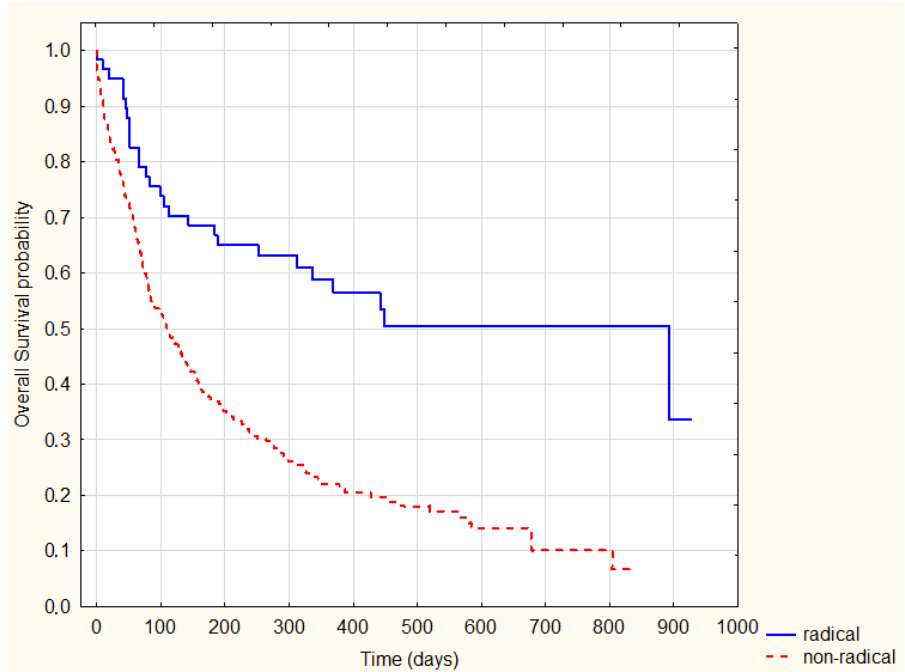
Figure 2. Kaplan–Meier Survival Analysis—radical vs. non-radical treatment, log-rank p =